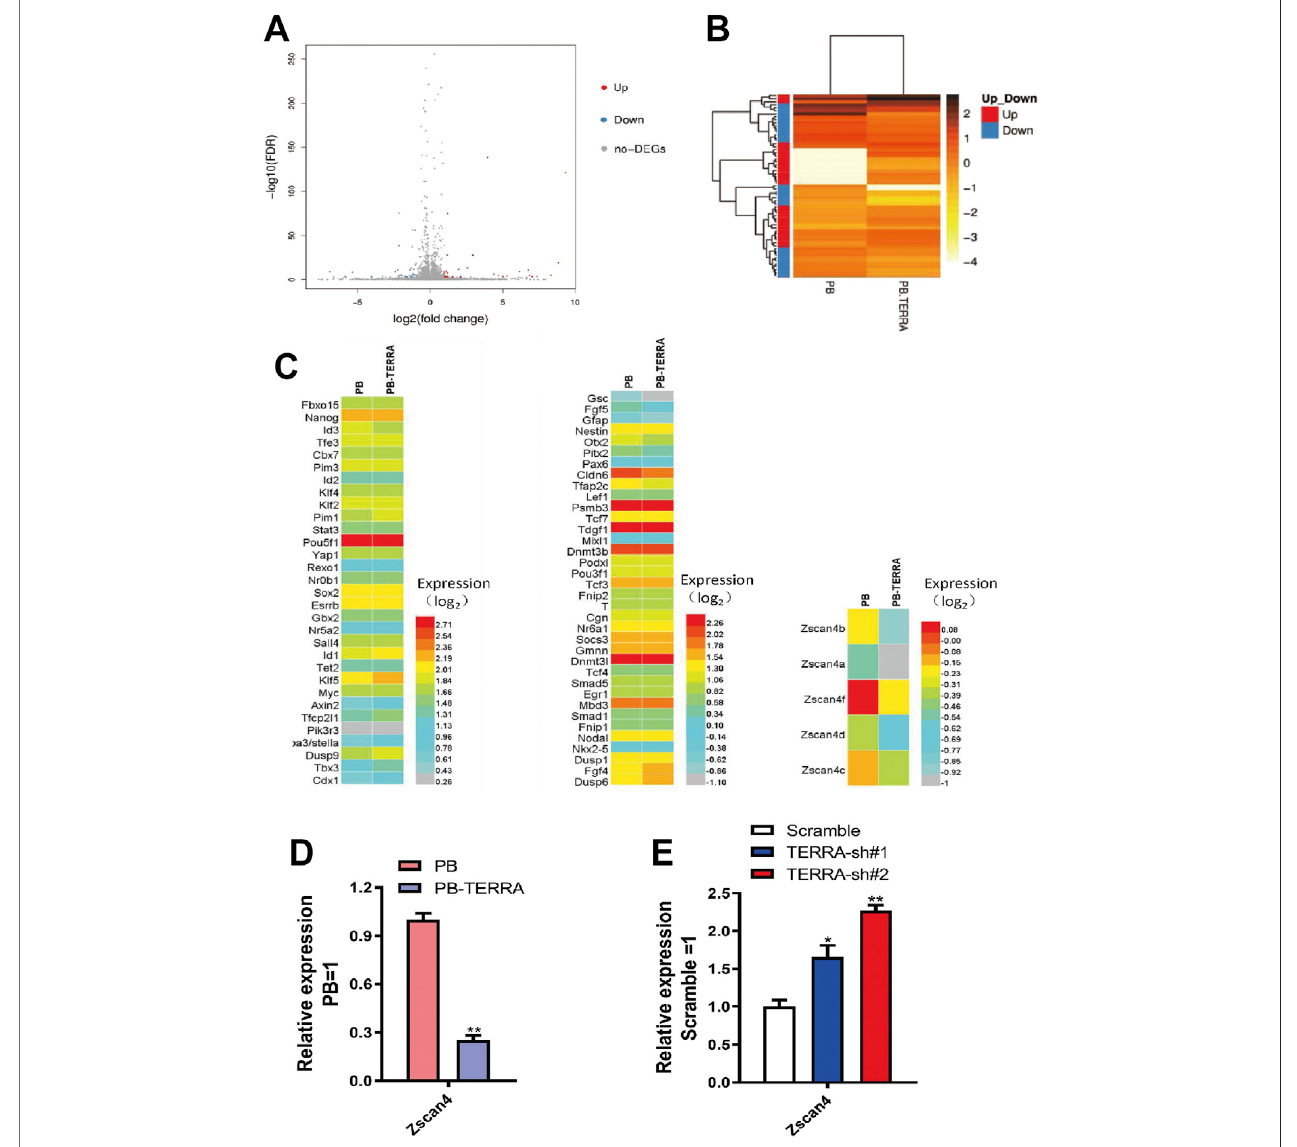
FIGURE 5 | TERRA with polyadenylation upregulates pluripotency genes and downregulates Zscan4 gene cluster. (A) Volcano-plot showed differently expressed genes in PB and PB-TERRA mESCs. (B) Heatmap showed differently expressed genes in PB and PB-TERRA mESCs. (C) Heatmap showed the transcriptome- resequencing data of the indicated gene expression pattern in PB and PB-TERRA mESCs. Left: pluripotent markers expression in PB and PB-TERRA mESCs. Middle: the expression of gene markers associated with differentiation in PB and PB-TERRA mESCs. Right: gene expression analysis of Zscan4b, Zscan4a, Zscan4f, Zscan4d, and Zscan4c in PB and PB-TERRA mESCs. (D) qRT-PCR analysis of Zscan4 expression levels in PB and PB-TERRA mESCs. Data were normalized to PB cells. Data represent means ± SD of three biological replicates. ** p < 0.01 vs. PB. (E) Zscan4 expression levels in TERRA knockdown cells were analyzed by qRT- PCR. Data represent means ± SD of three biological replicates. * p < 0.05, ** p < 0.01 vs. Scramble control.